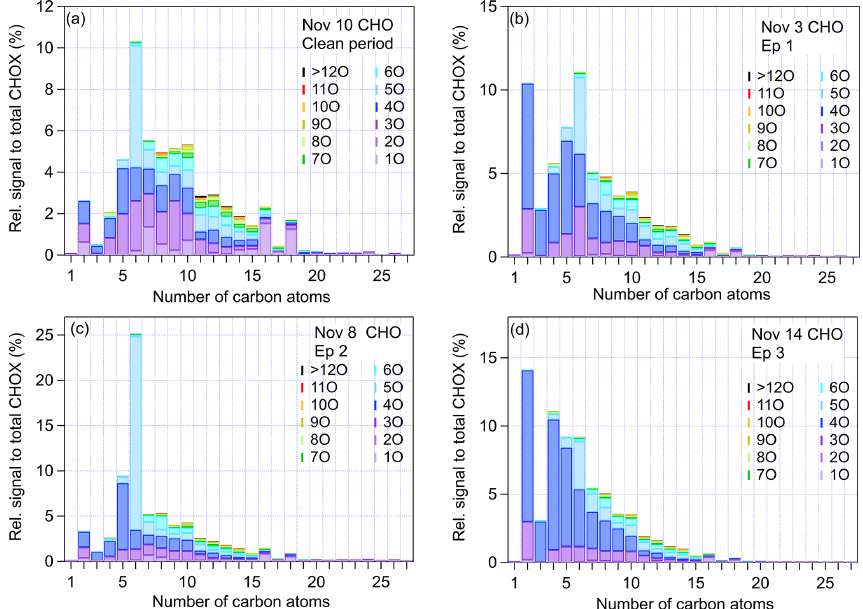
Figure 3. Signal fractions to total CHO X for CHO compounds with different numbers of oxygen and carbon atoms in (a) the clean period (10 November), (b) Ep1 (3 November), (c) Ep2 (8 November), and (d) Ep3 (14 November). The same plots for CHON compounds are displayed in Fig.